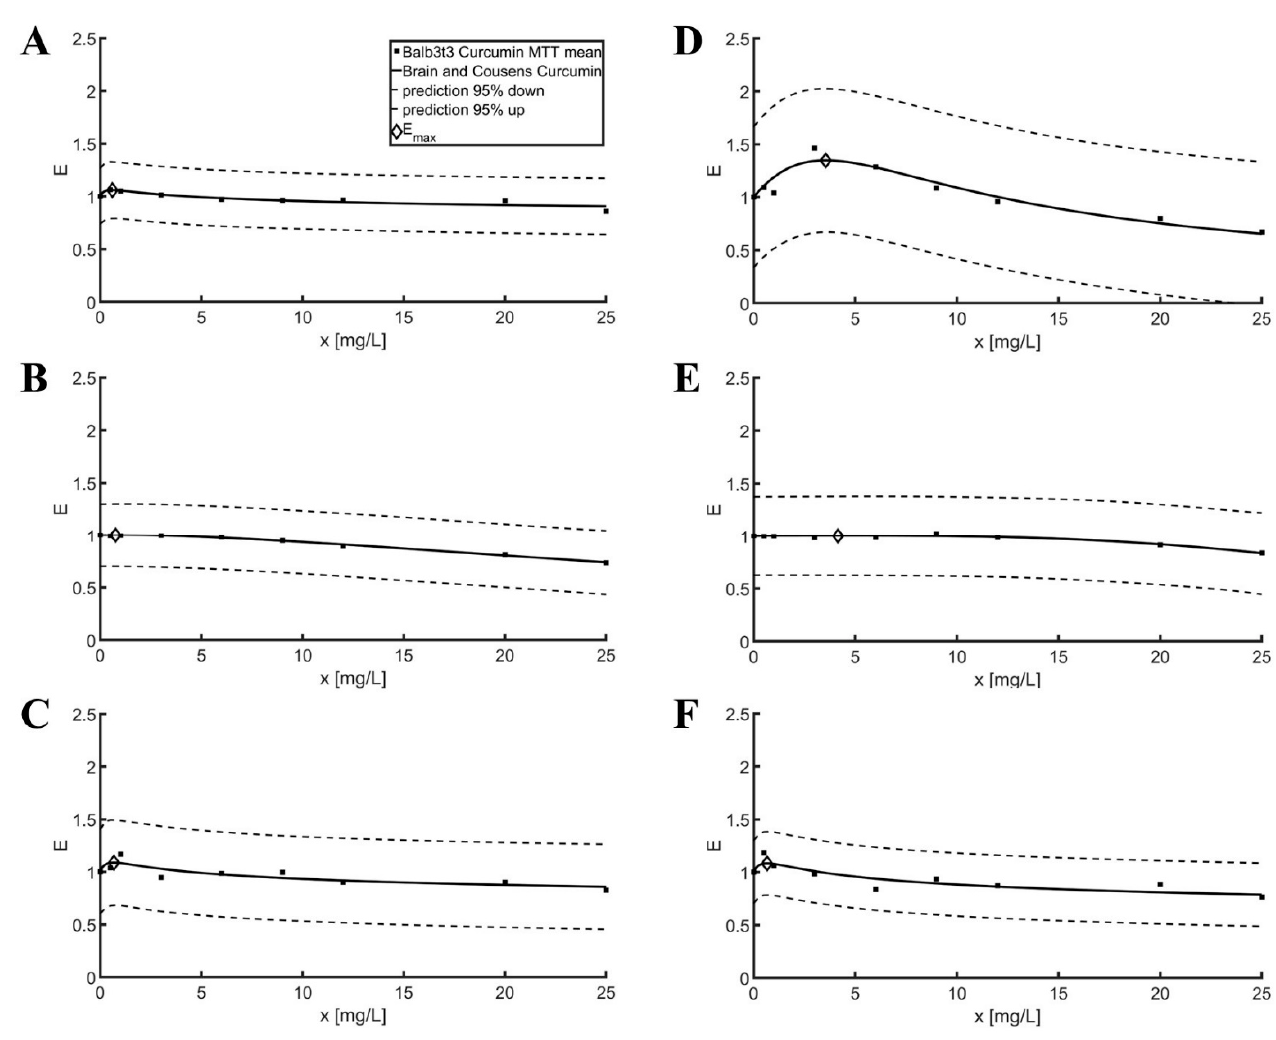
Figure 1. Brian and Cousens model curve fitting with 95% prediction bounds for the MTT assay. ( A ) Curcumin—Balb3t3; ( B ) Resveratrol—Balb3t3; ( C ) Baicalin—Balb3t3; ( D ) Curcumin—L929; ( E ) Resveratrol—L929; ( F ) Baicalin—L929. Table 1. Estimated Brian and Cousens model parameters and values of the maximum relative effects for MTT assays.